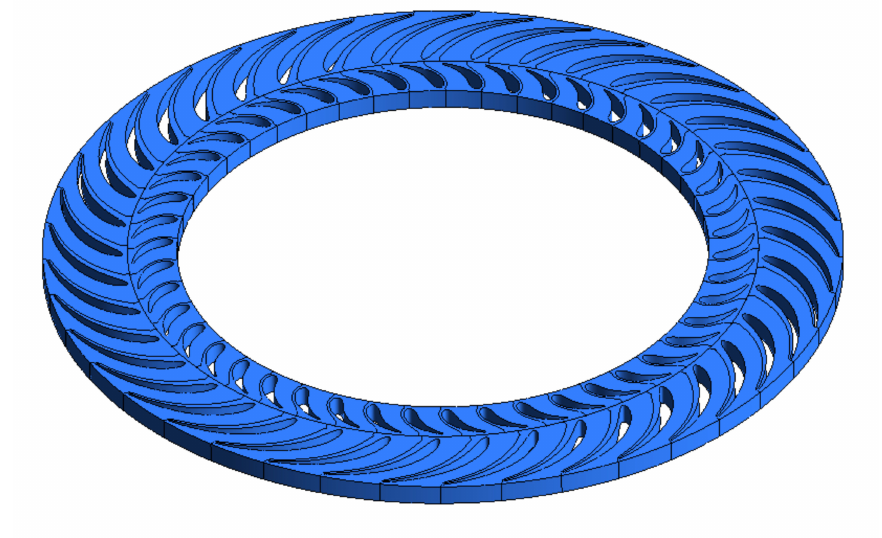
Figure 5. Full geometry of the radial outflow